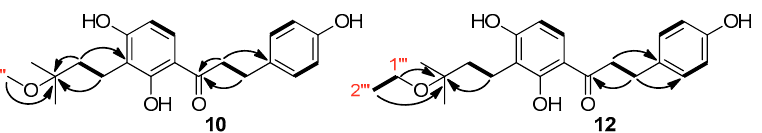
Figure 3. Selected HMBC ( 1 H → 13 C) and COSY ( 1 H − 1 H) correlations of compounds 10 and 12 . Table 2. 1 H- and 13 C-NMR data for 10 – 13 .